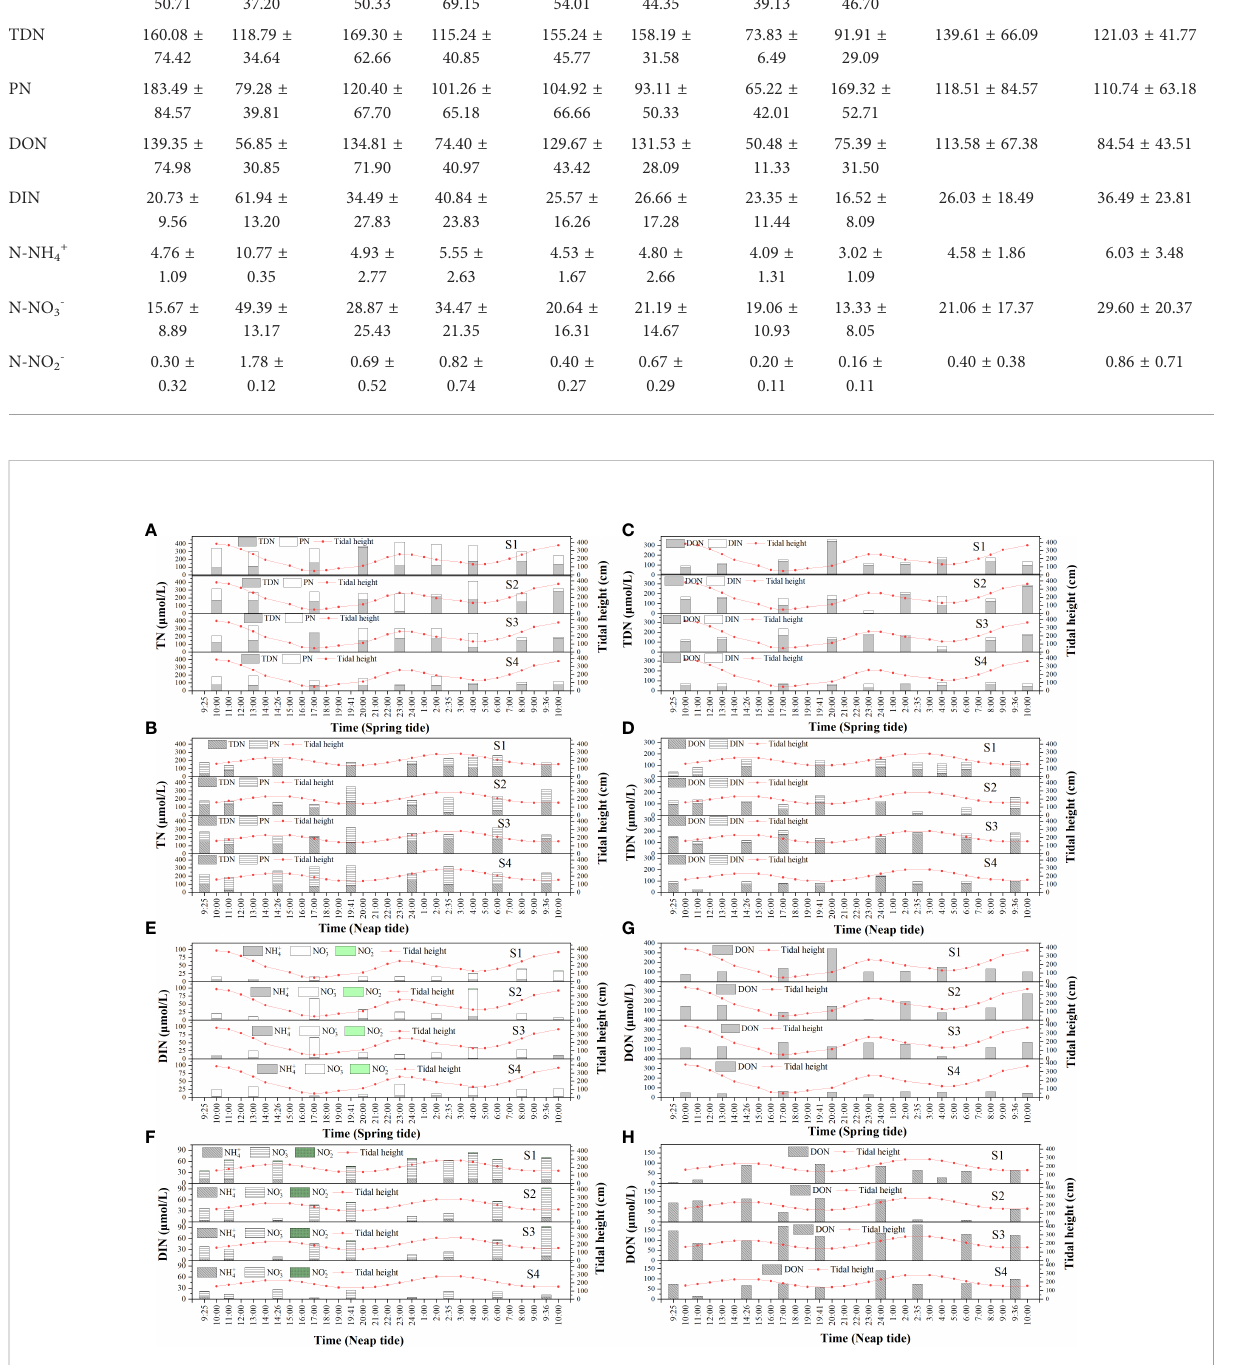
FIGURE 2 Dynamics of TN (A), , TDN (C) , DIN (E) and DON (G) during the spring tide in SDB and dynamics of TN (B) , TDN (D) , DIN (F) and DON (H) during the neap tide in SDB.